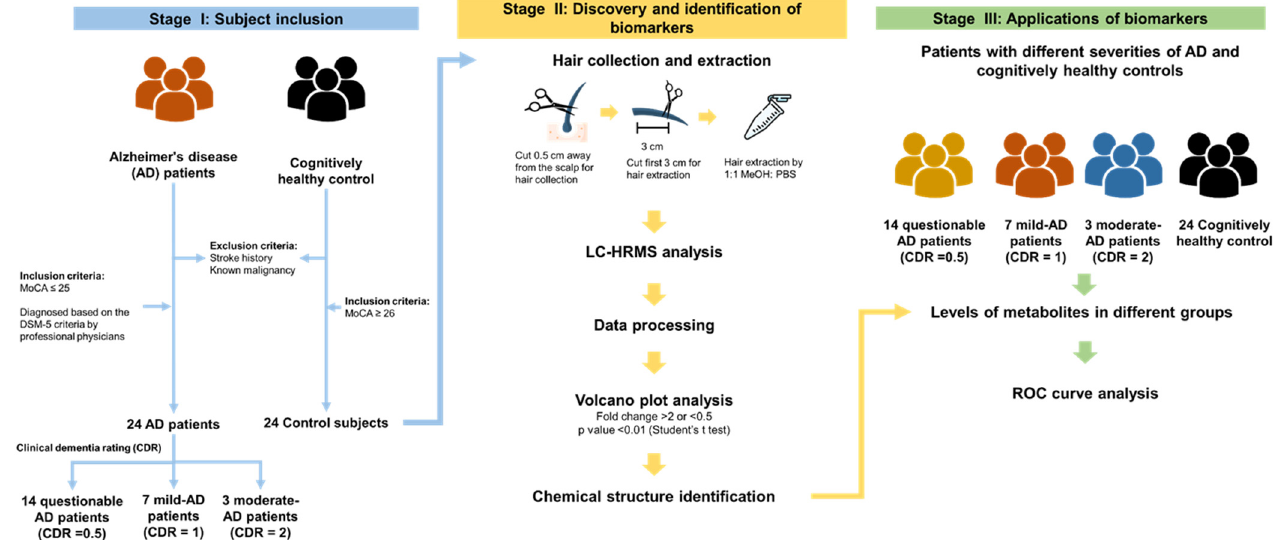
Figure 1. Study design of hair biomarkers of Alzheimer’s disease (AD) discovery and interpretation using a high-resolution mass spectrometry (HRMS)-based untargeted metabolomics approach. A total of 24 AD patients and 24 control subjects without stroke history and known malignancy were recruited in this study. All participants underwent MoCA test, and the control subjects included a MoCA score of higher than 26. The AD patient underwent further CDR assessment to quantify the severity of the symptoms of dementia.